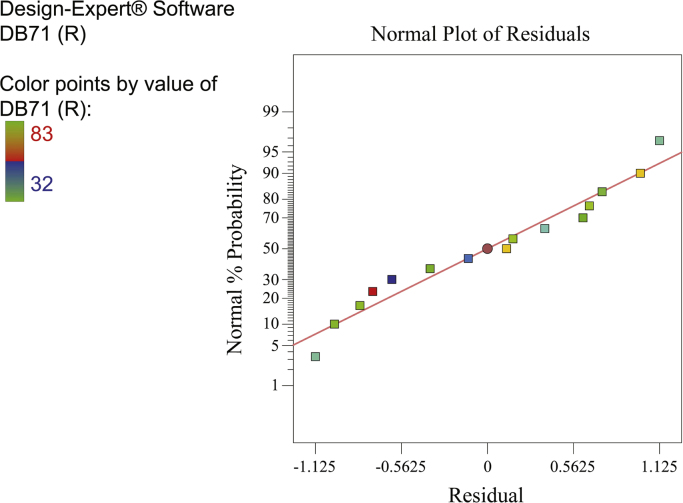
Normal probability plot of residual values.